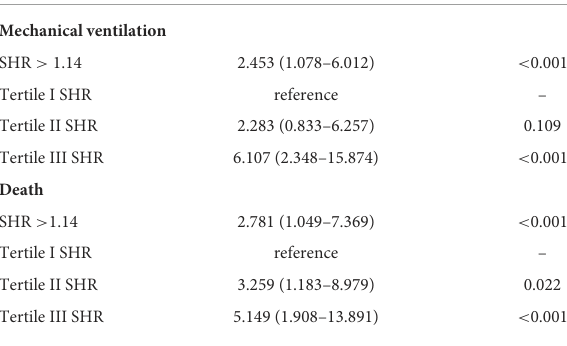
TABLE 5 Multivariate logistic models with use of mechanical ventilation (top panel) or death (bottom panel) occurring within 60 day from hospital admission as the dependent